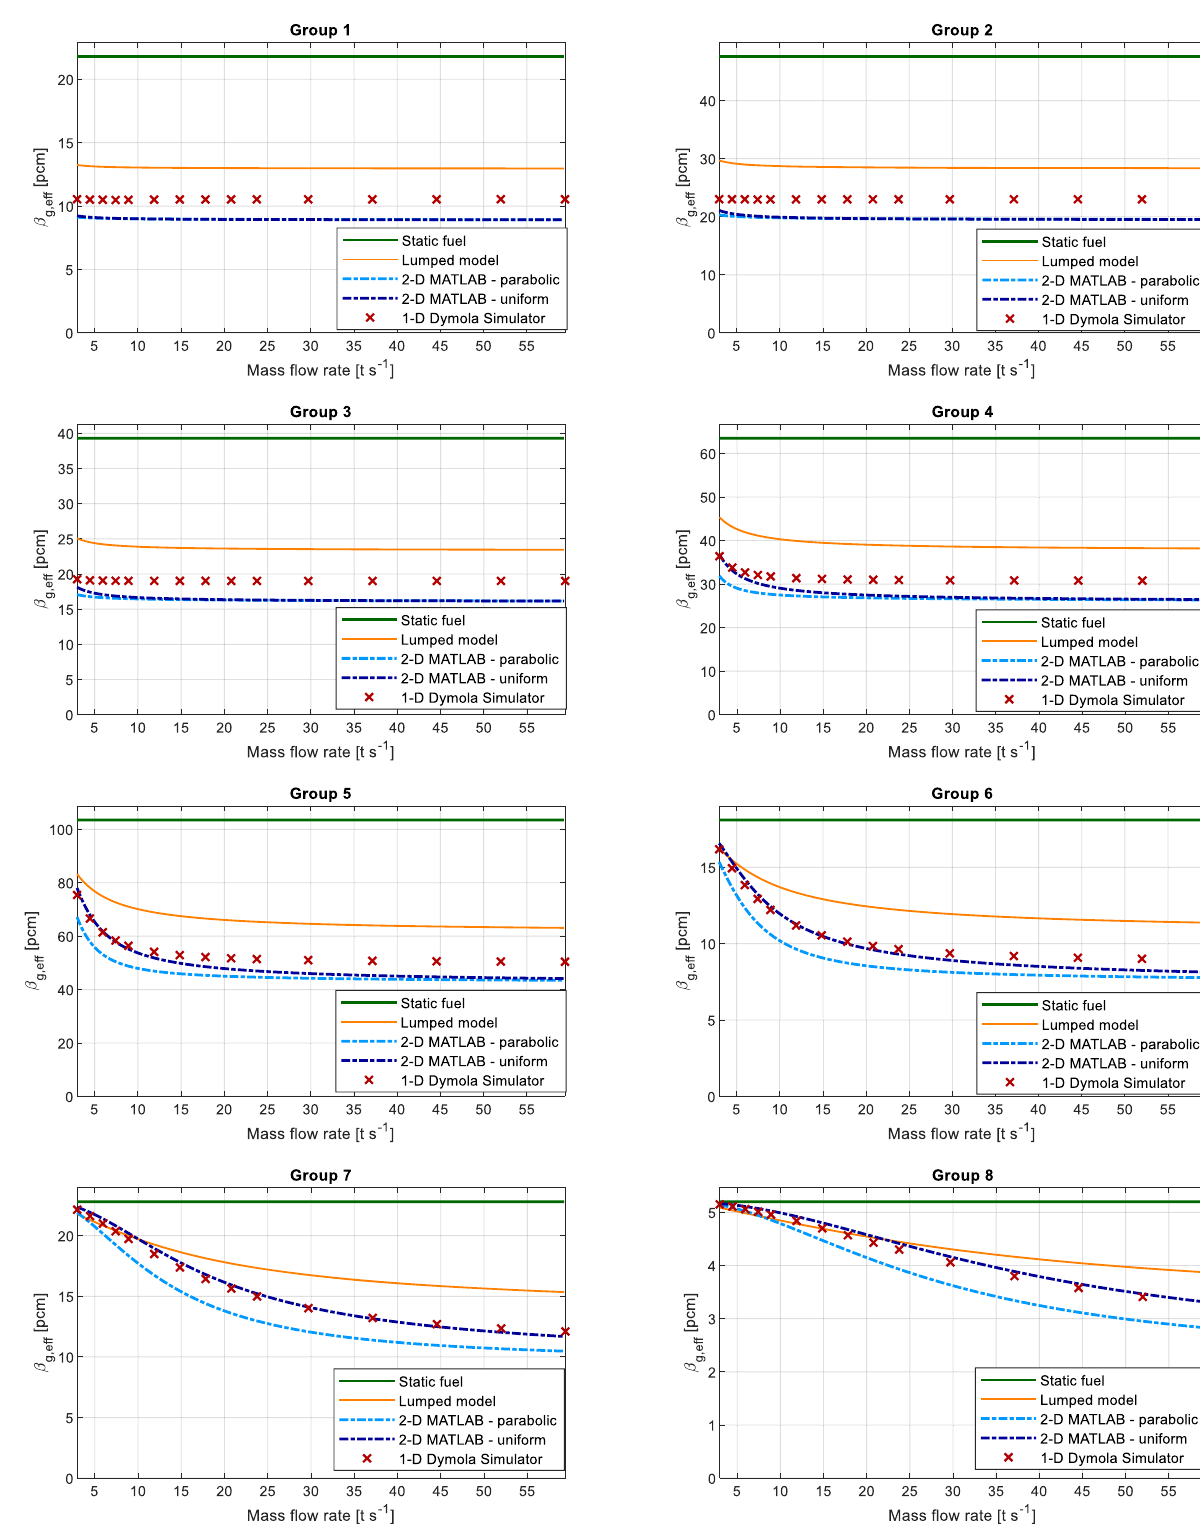
Fig. 11. Trend of the effective delayed neutron fractions versus fuel salt mass fl ow rate as predicted from the different models. Delayed groups 1 –